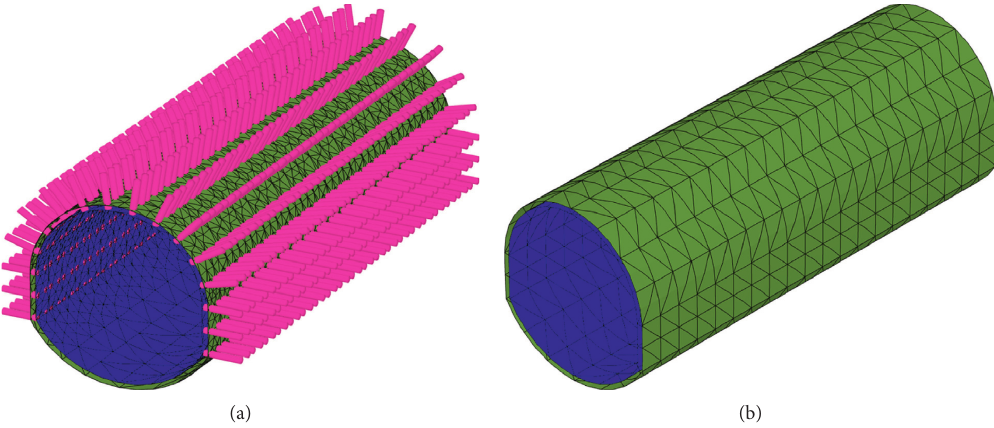
Figure 4: Support structure model: (a) lining+geogrid +anchor; (b)